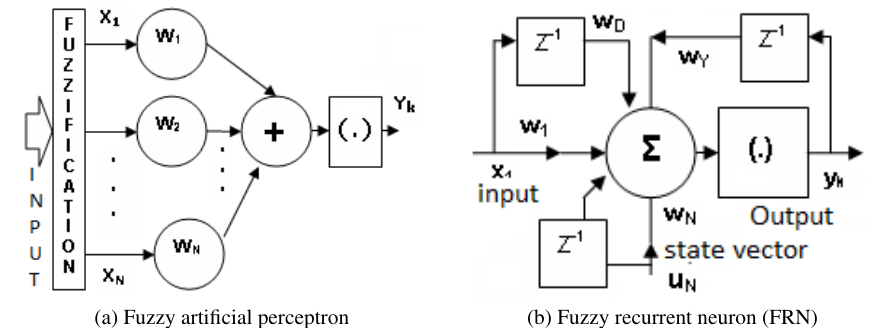
Figure 4. Fuzzified neural processing